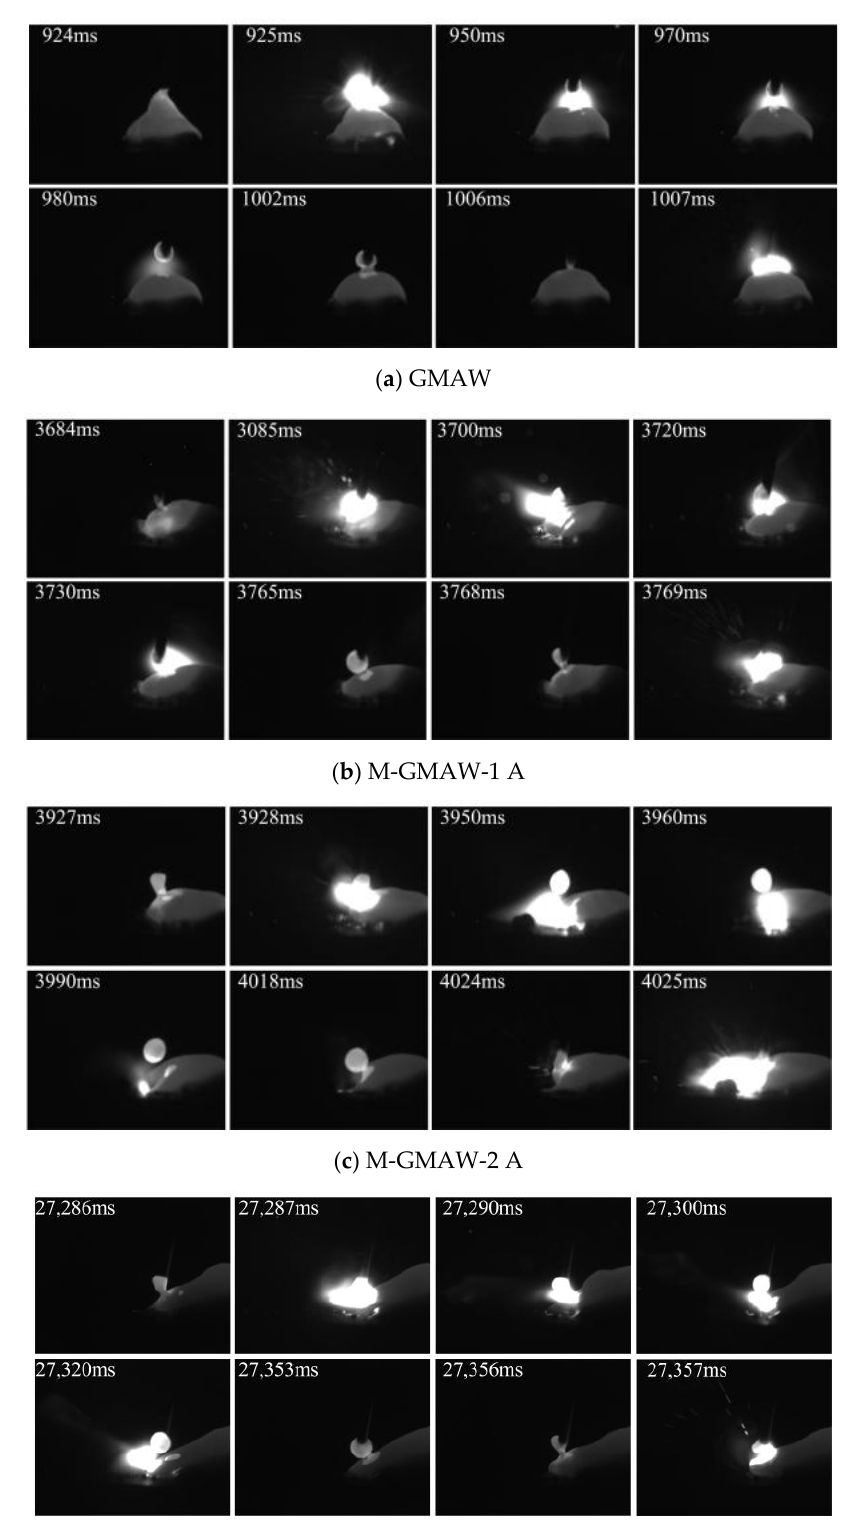
Figure 4. Wire feeding speed of 4 m/min.